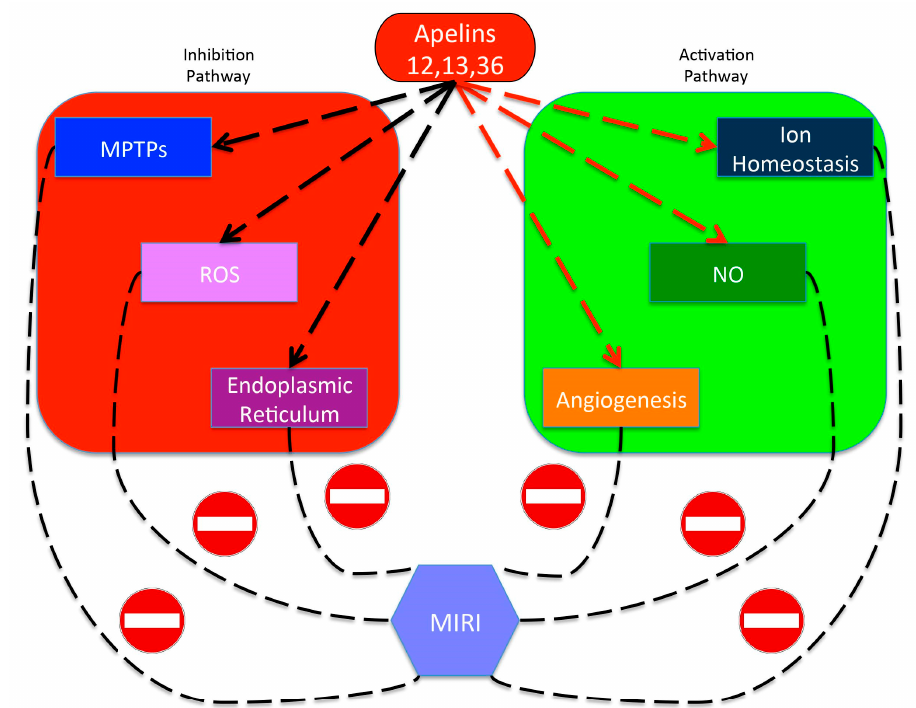
Figure 3. Protective effects of apelins against MIRI. A large body of evidence suggests that apelin-12, -13, and -36 ameliorate MIRI. These apelin isoforms trigger inhibition and activation pathways during MIRI. In particular, they inhibit MPTPs opening, ROS formation, and ER stress. Consistently, they activate ionic channel function for ion homeostasis, NO synthesis, and angiogenesis. All these effects protect the heart against MIRI. MIRI, myocardial ischemia-reperfusion injury; MPTPs, mitochondrial permeability transition pores; ROS, reactive oxygen species; ER, endoplasmic reticulum; NO, nitric oxide.